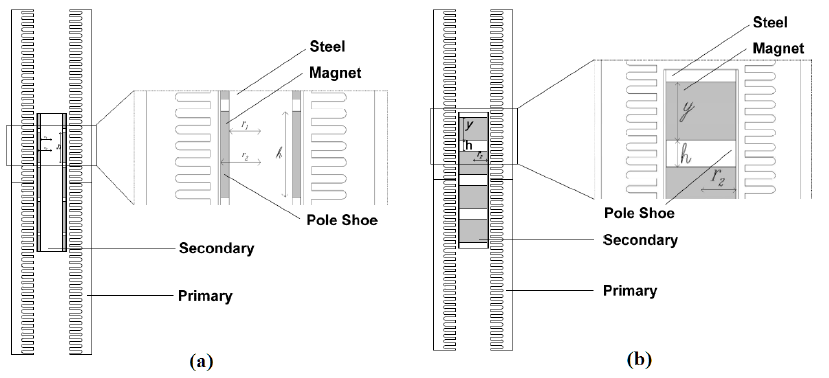
Figure 5. Two main topologies of permanent magnets in linear electric motors: ( a ) surface-mounted; and ( b ) buried magnet arrangements (van Zyl